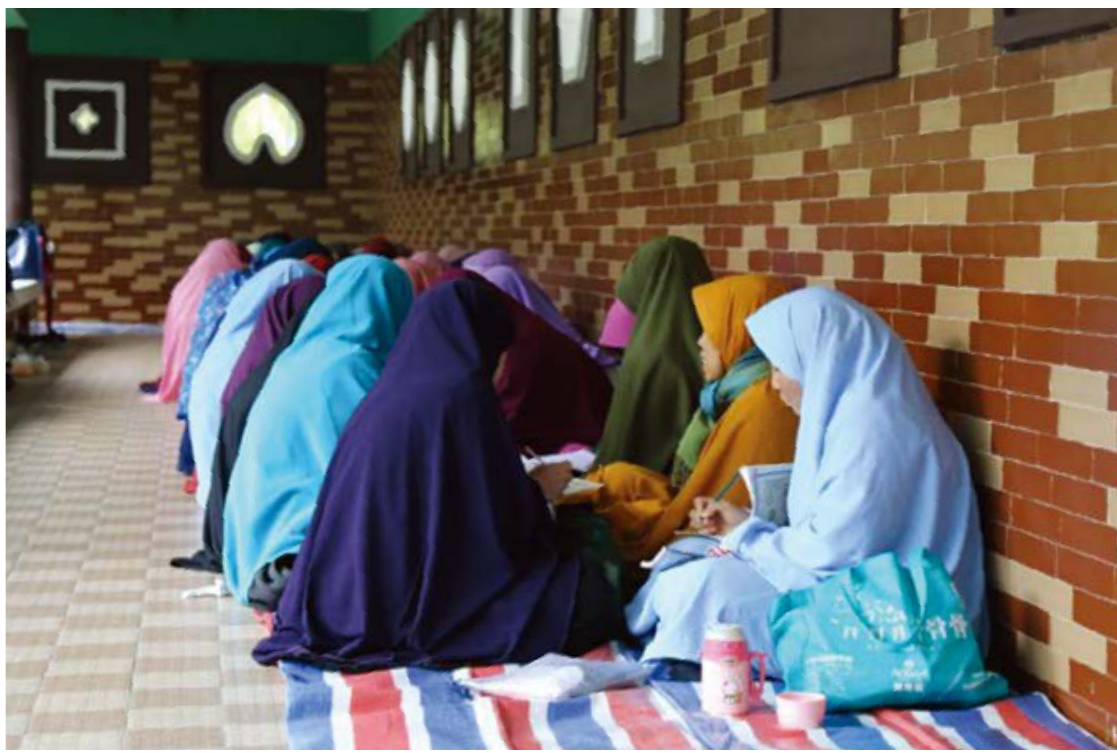
Figure 5: Studying the Quran, Kowloon Park。 Source: Tim Tang 2018. Figure 6 (opposite page): The same space at night, Kowloon Park. Source: Liao Jiaming